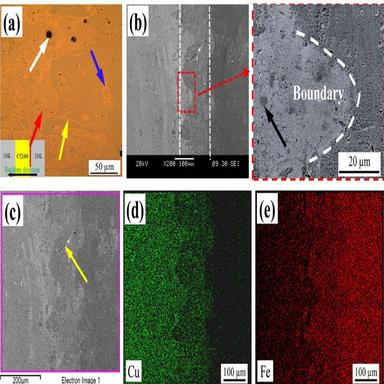
Microstructure, morphology and chemical element distribution at L/C interface: (a) Optical image; (b) SEM image; (c) (d) (e) Fe and Cu element distributions at the interface using EDS mapping.